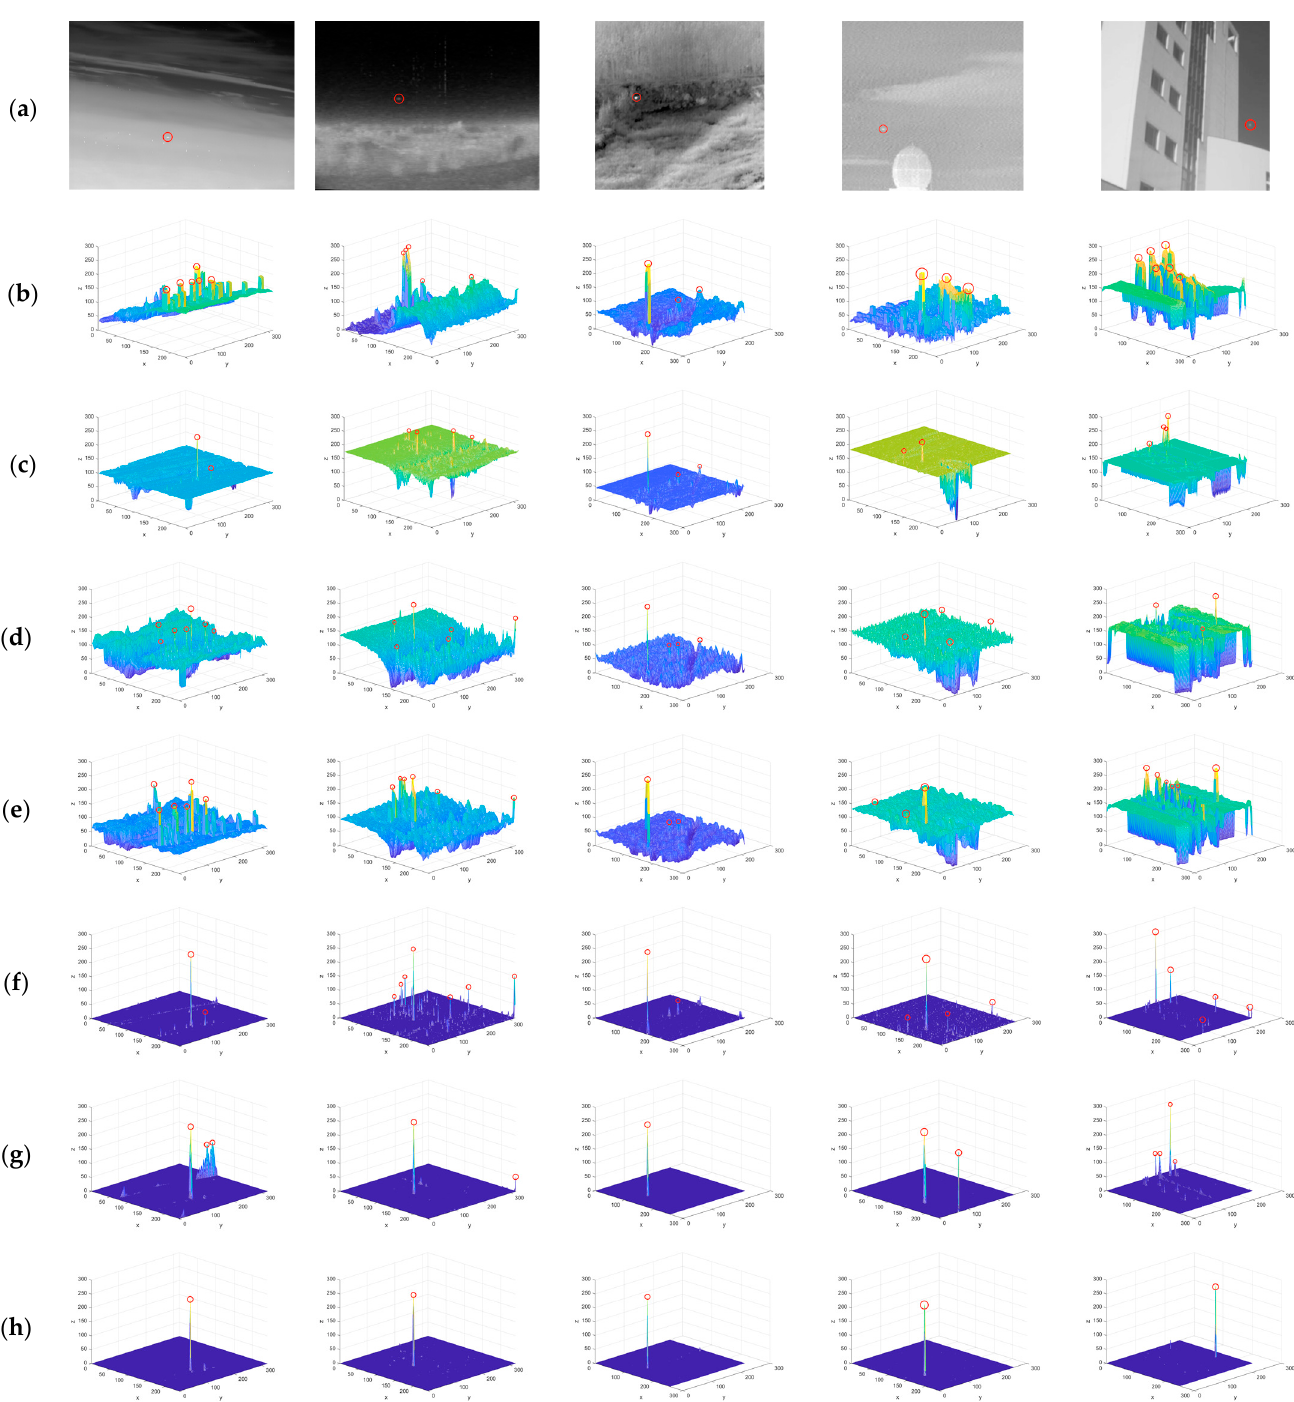
Figure 4. Processing results of different algorithms. ( a ) Original image, ( b ) LCM, ( c ) MPCM, ( d ) TLLCM, ( e ) RLCM, ( f ) ADMD, ( g ) VAR-DIFF, and ( h ) proposed method. Note that the gray values of all images are normalized to the [0–255] interval.